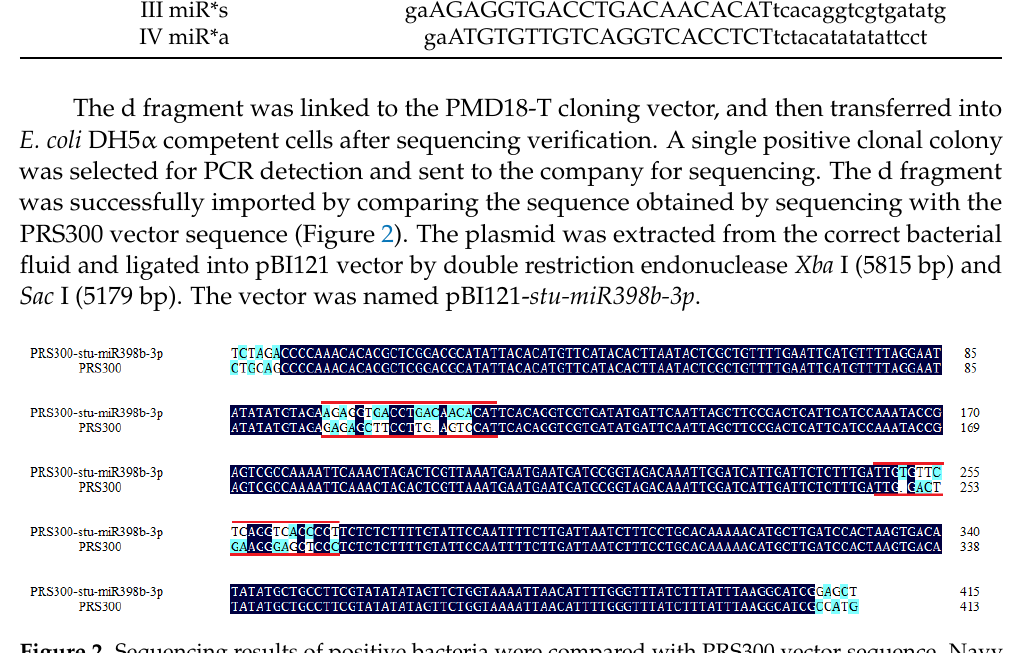
Figure 2. Sequencing results of positive bacteria were compared with PRS300 vector sequence. Navy blue represents the same bases of the two sequences. The sky blue represents the different bases of the two sequences. The red lines represent the insertion position of stu-miR398b-3p .